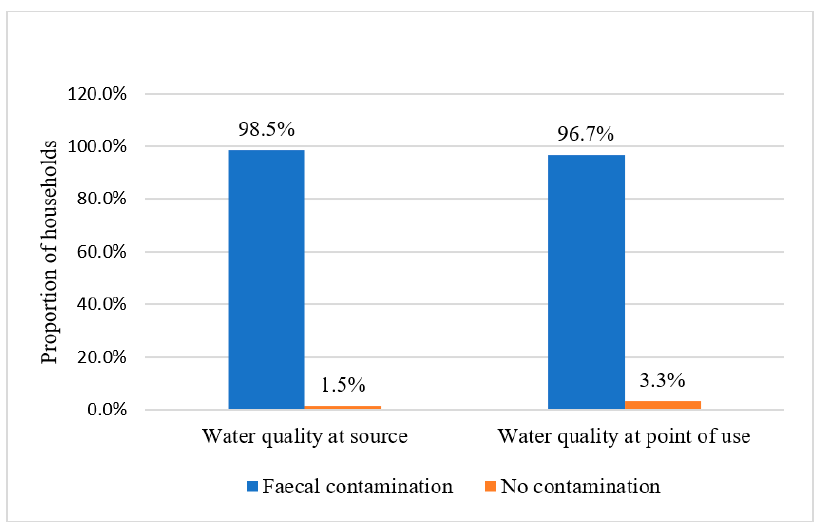
Figure 4. Fecal contamination of water at source and point of use during monsoon season ( N = 209).